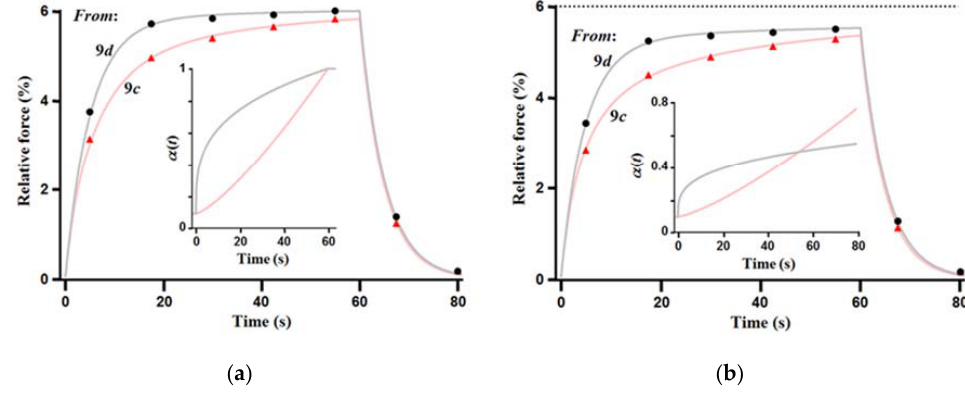
Figure 6. Fits of Equation (19) to measured stress transients from [12]. Fits in ( a , b ) have essentially identical shapes, but differ by ~6% in the relative force, due to an assumed steady state force Δ F ( ∞ ) = Δ F (55) being used in the fits in ( a ), and Δ F ( ∞ ) = 1.06 × Δ F (55) being used in ( b ). The dashed line in ( b ) is a reference that shows the maximum value reached in ( a ). The insets show that markedly different functions describing the fractional heating function α ( t ) were required to fit the same data in ( a , b ) with Equation (19). As explained in the text, experimental measurements of temperature distribution or the tensioning force F o , if available, could have been used to resolve this degree of freedom.